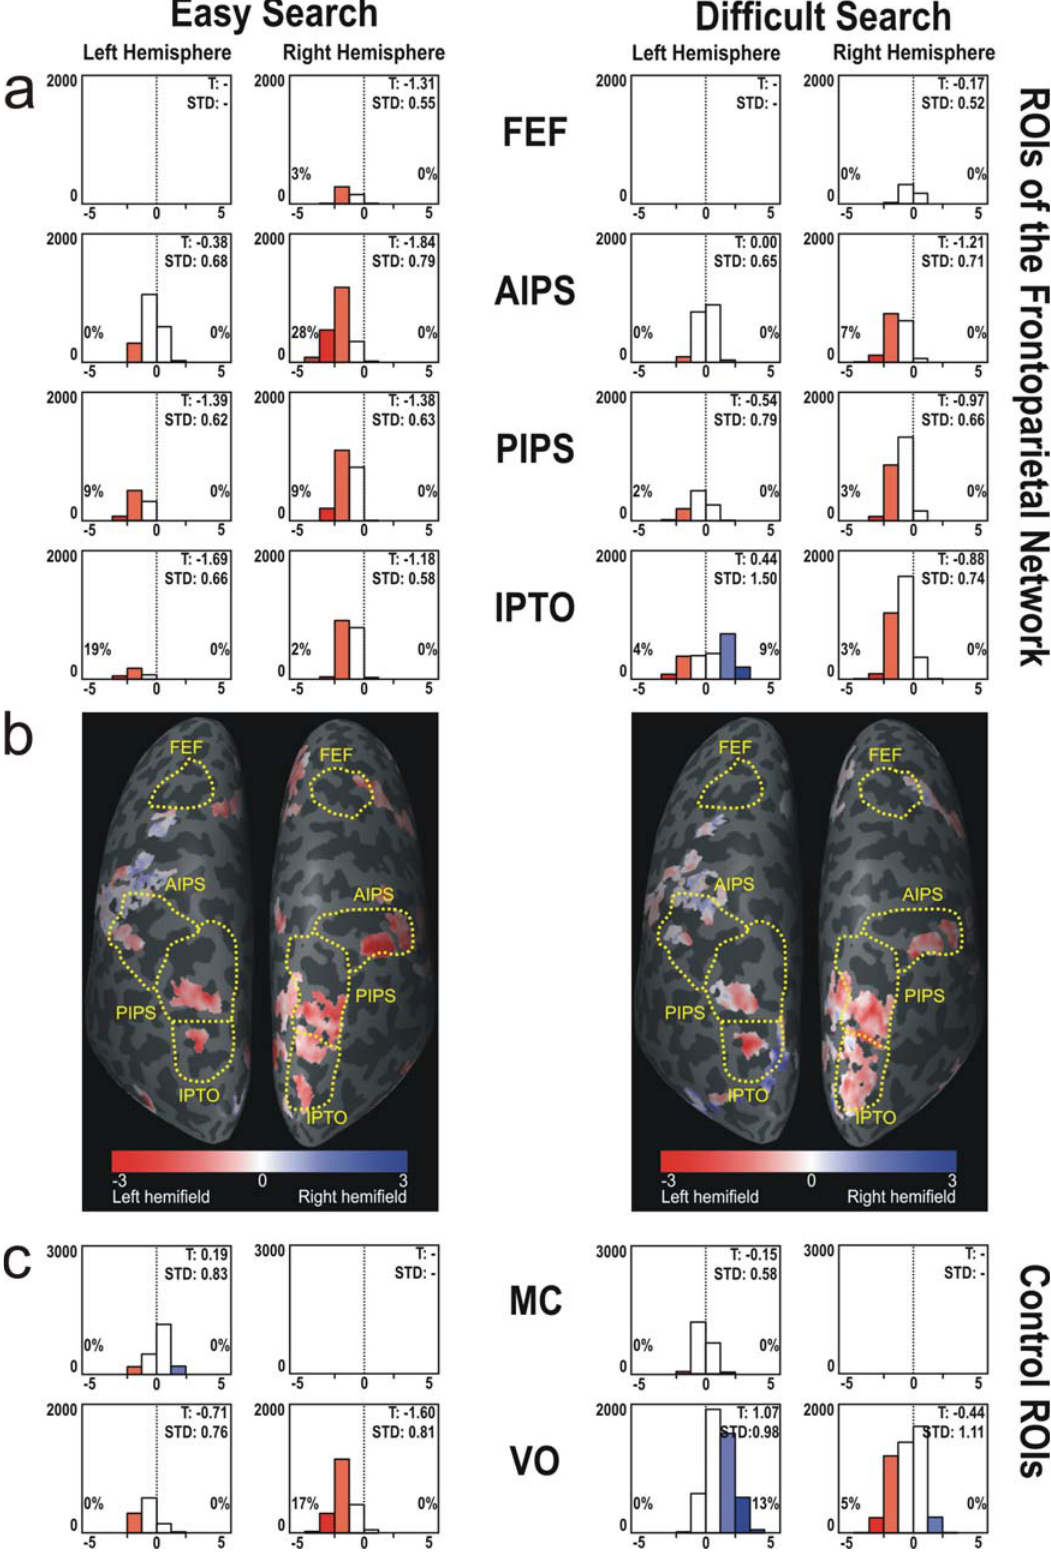
Figure 3. Contralateral preference of activated voxels during easy and difficult search conditions. Contralateral preference visualized by t-tests for all voxels activated by easy search and difficult search conditions (p , 0.005, RFX, cluster threshold: 50 mm 2 ). The color convention and the significance level for hemifield preference are described in Fig. 2. (a) Histograms with t-values for all activated voxels within predefined ROIs of the dorsal FPN. The range of t-values represented by each bar is 1.13. The significance level (p , 0.05) for contralateral preference to the left ( 2 ) or right ( + ) is indicated by black lines on the x-axis of each histogram. As in Figure 2, the percentage of voxels with a significant contralateral preference for the left or right hemifield is given on the appropriate side of the histograms. (b) Dorsal posterior view of the flattened left and right hemisphere with representation of t-values on the surface. (c) Histograms with t-values for all activated voxels within control ROIs MC (motor cortex) and VO (visual occipital). T: mean t-value of activated voxels; STD: standard deviation of t-values; Yellow dotted lines: predefined anatomical ROIs. doi:10.1371/journal.pone.0003167.g003 PLoS ONE |